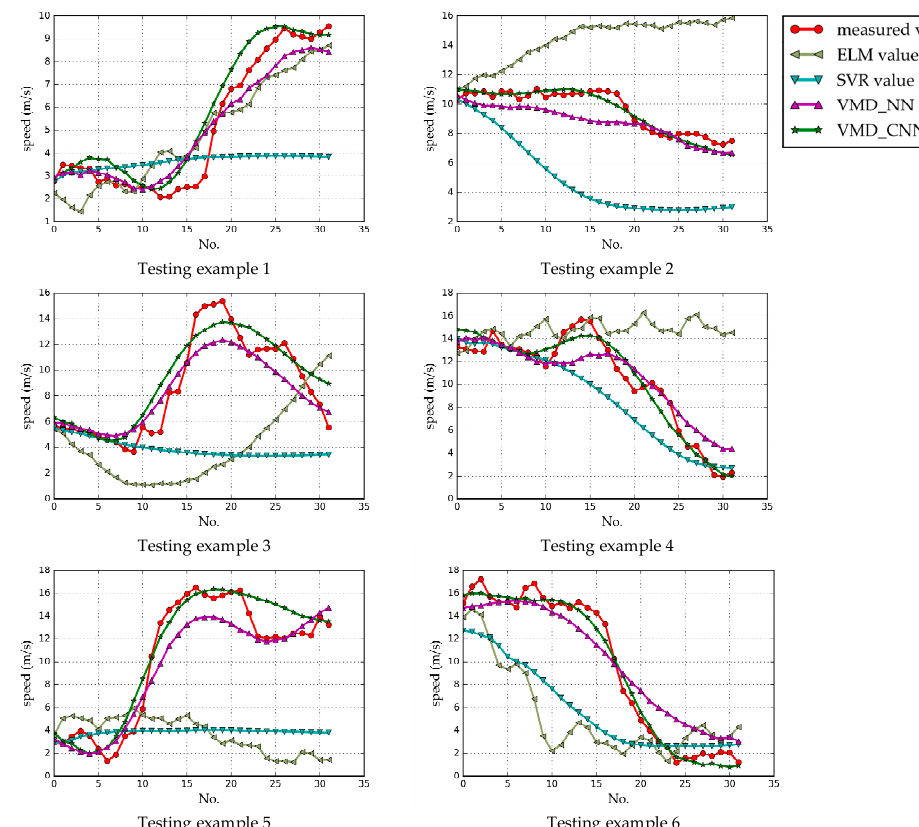
Figure 8. The multi-step forecasting results of the methods.